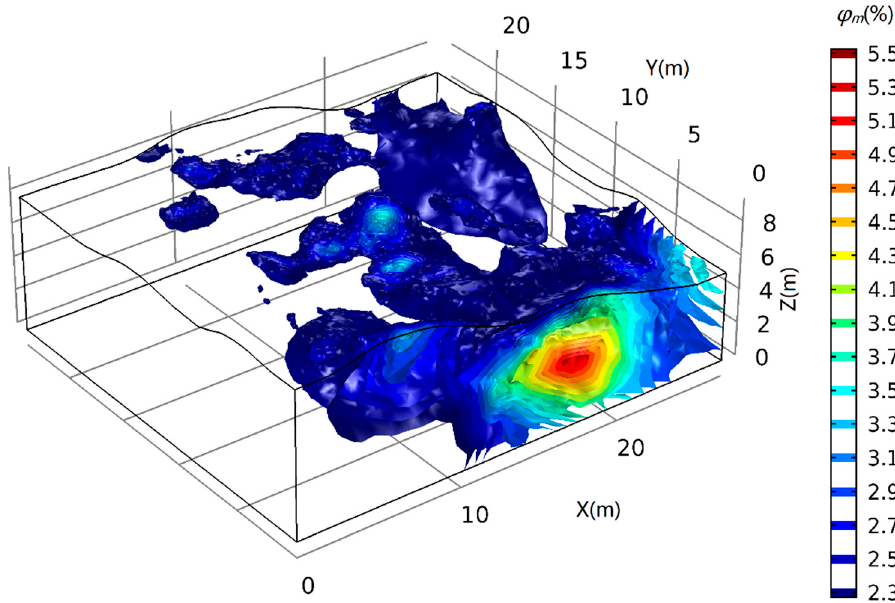
Figure 27. Tomography of the volume fraction of metal (in %) in a slag heap that corresponds to an archeological site. The tomogram is directly determined by using the chargeability tomogram. We use a threshold chargeability for the background of the chargeability: M b = 0.08 ≈ R (from experimental data performed in the laboratory by using materials from the archeological test site). Modified from [98].